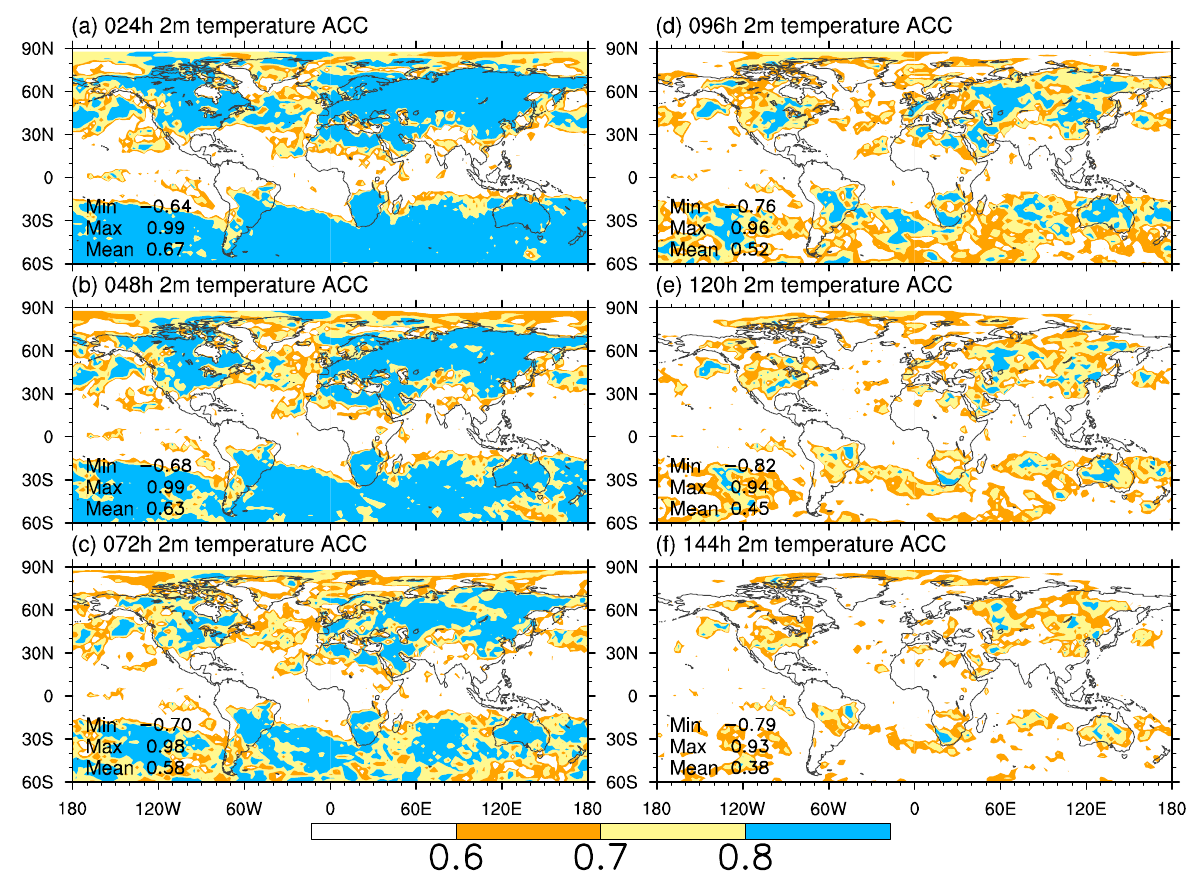
Figure 6. Same as Figure 2, but for air temperature at 2 m (units: K).